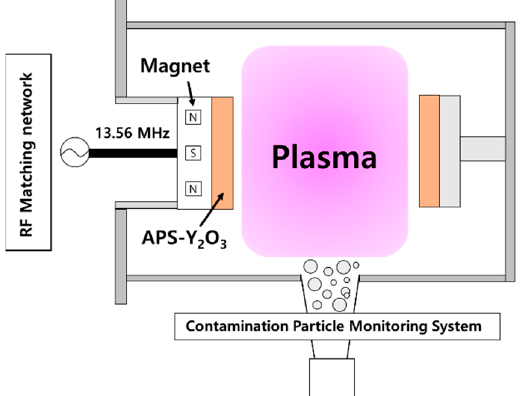
Figure 2. Schematic of a vertical conductively coupled plasma etching system.